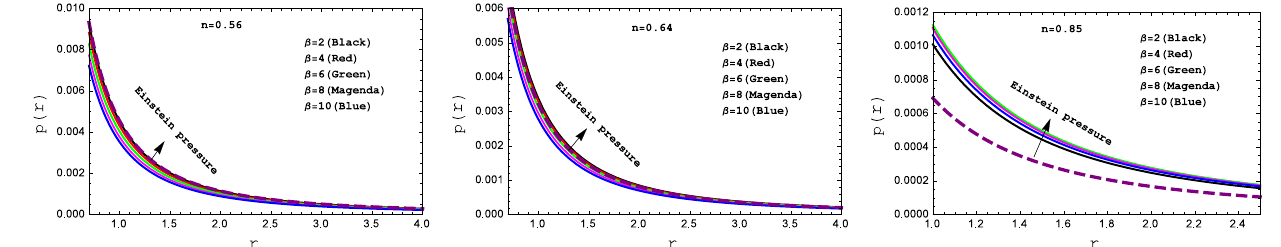
Figure 2. Behavior of the “pressure” with respect to the radial coordinate “ r “ for the compact stars PSR J1614-2230 ( left panel ), Vela X-1 ( middle panel ) and 4U 1538-52 ( right panel ) corresponding to the numerical value of constants A and B from Table 2 and for different values of β . Table 1. Numerical values of constants for three well-known celestial compact stars. Compact Star